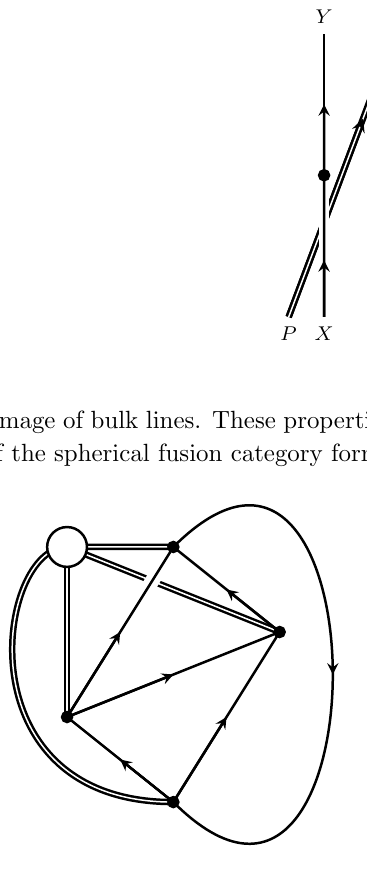
Figure 20 . The basic tetrahedron graph in the Turaev-Viro construction of the partition function Z f ( M; (cid:12) 2 ) of the shadow theory in the presence of a background 2-connection (cid:12) 2 . A (cid:5) line (shown as double line in the (cid:12)gure) leaves the vertex if the dual face has (cid:12) 2 = 1. We let such lines meet without crossing each other in the region denoted by a disk in the graph. Di(cid:11)erent ways of joining the lines in the disk are equivalent because of the property of (cid:5) lines shown in (cid:12)gure